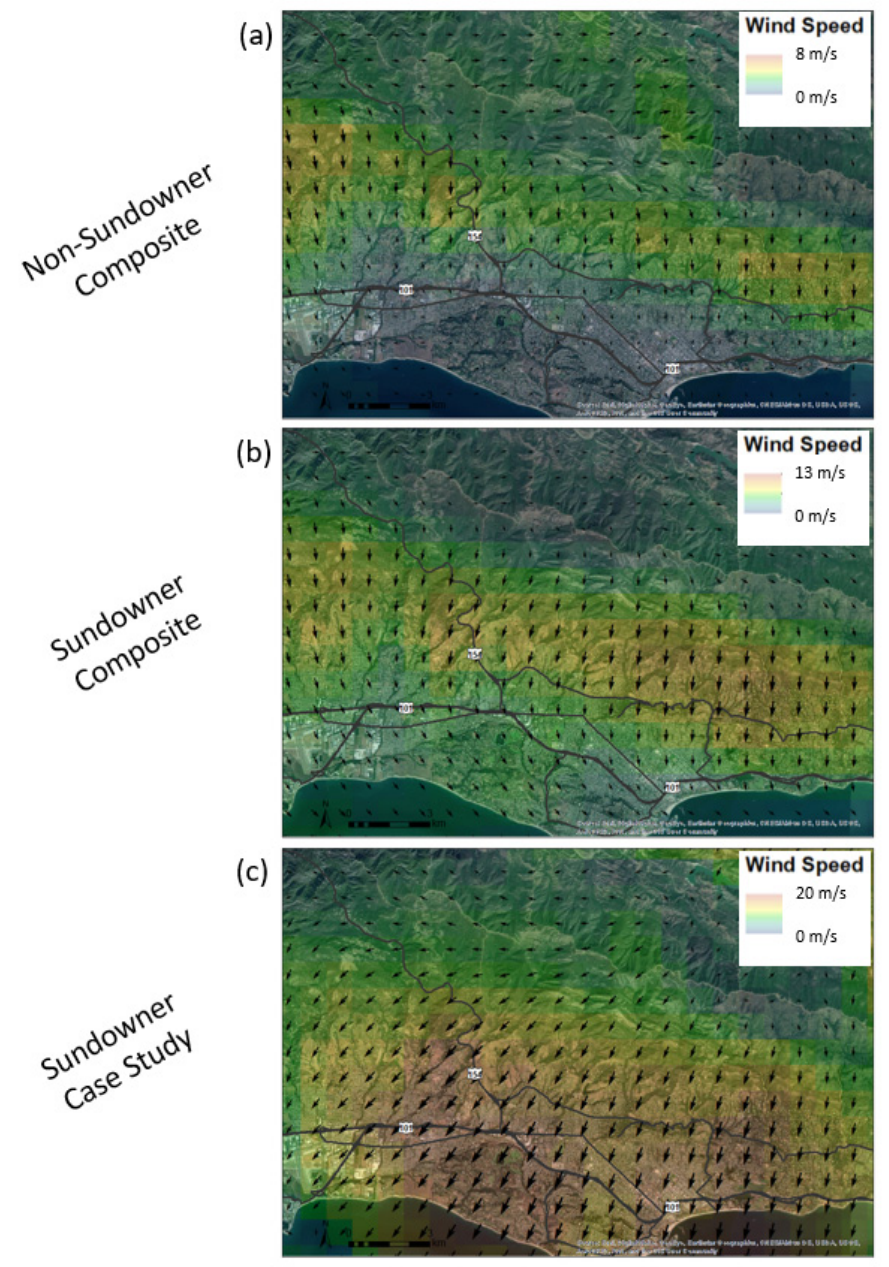
Figure 3. Gridded wind rasters using WRF data for ( a ) non-Sundowner composite, ( b ) Sundowner composite, and ( c ) Sundowner case study at 20 PST on 14 April 2005. Wildfire risk maps were created for the three ignition modeling methods and the three gridded wind scenarios. Fires were ignited at every ignition point for the respec- tive method. The ignition time was set to 2000 PST, aligning with typical Sundowner on- set in the central and eastern parts of the SYM [23]. Fires were simulated using FARSITE for three hours after ignition.